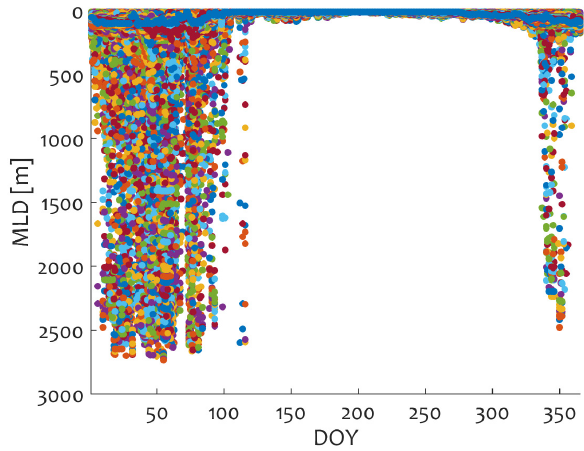
Figure 2. Seasonal variability of MLD at different locations in the Western Mediterranean in